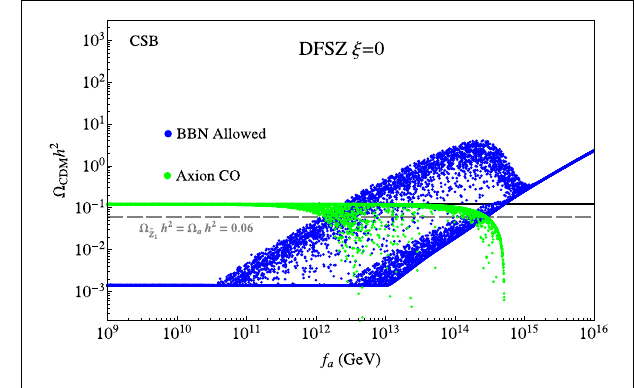
FIGURE 3 | The wino-like WIMP and axion relic densities from a scan over SUSY KSVZ parameter space for the CSB benchmark case with ξ = 1 . The gray dashed line shows the points where DM consists of 50% axions and 50% neutralinos.